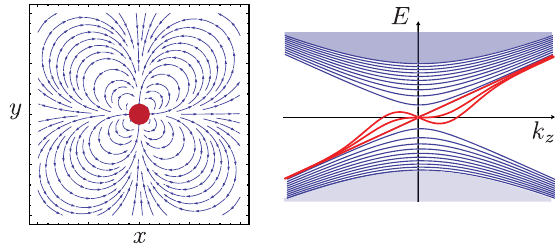
FIG. 4. Dirac string. (Left) Spatial winding of mass parameters around a Dirac string going out of the paper represented by the center red dot. Stream lines represent the vector field m ð r Þ ¼ ½ m r Þ ; m r Þ(cid:3) . (Right) Energy spectrum of chiral Dirac x ð y ð fermions. Blue bands represent bulk continuum. Red bands correspond to chiral Dirac fermions localized along the